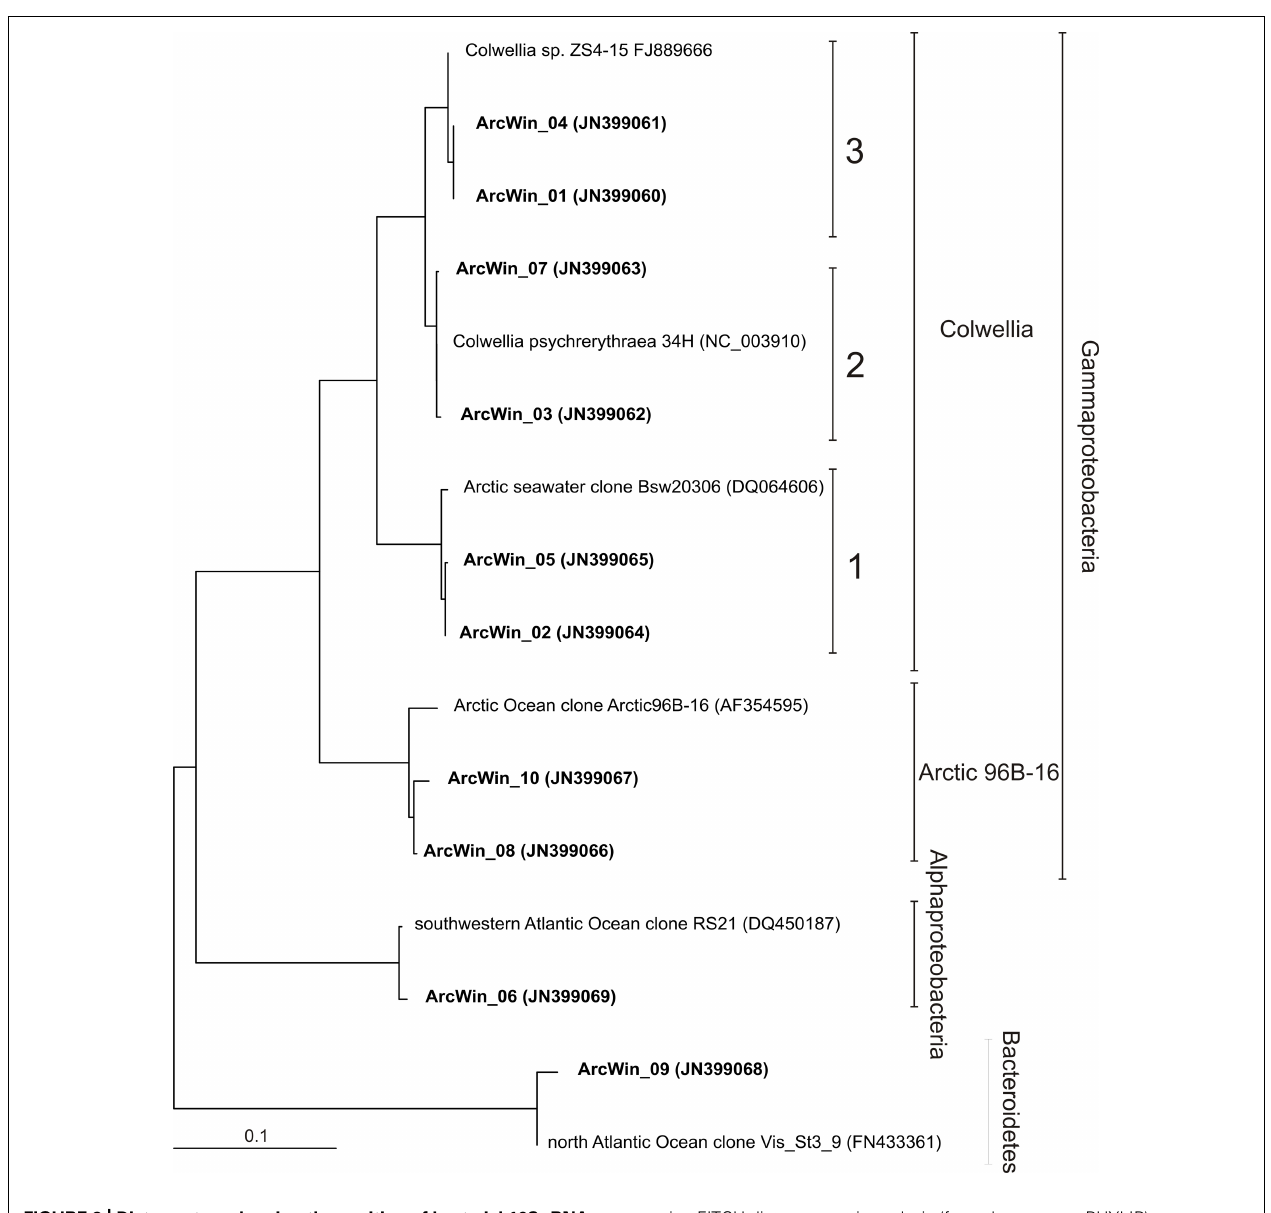
FIGURE 2 | Distance tree showing the position of bacterial 16S rRNA gene sequences. Sequences from this study are in boldface type. Analyses are inferred from 16S rRNA gene sequences (length ca. 900 bp)